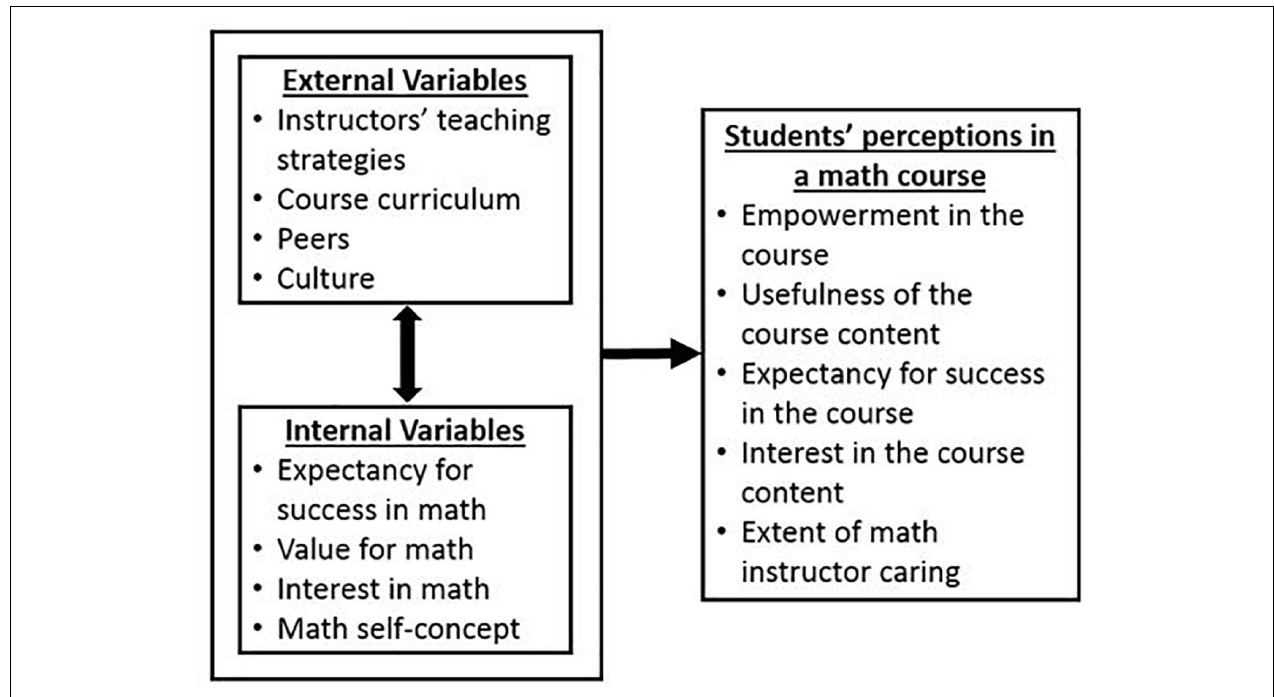
FIGURE 1 | A few of the many possible antecedents of students’ perceptions in a mathematics course [Adapted from Jones